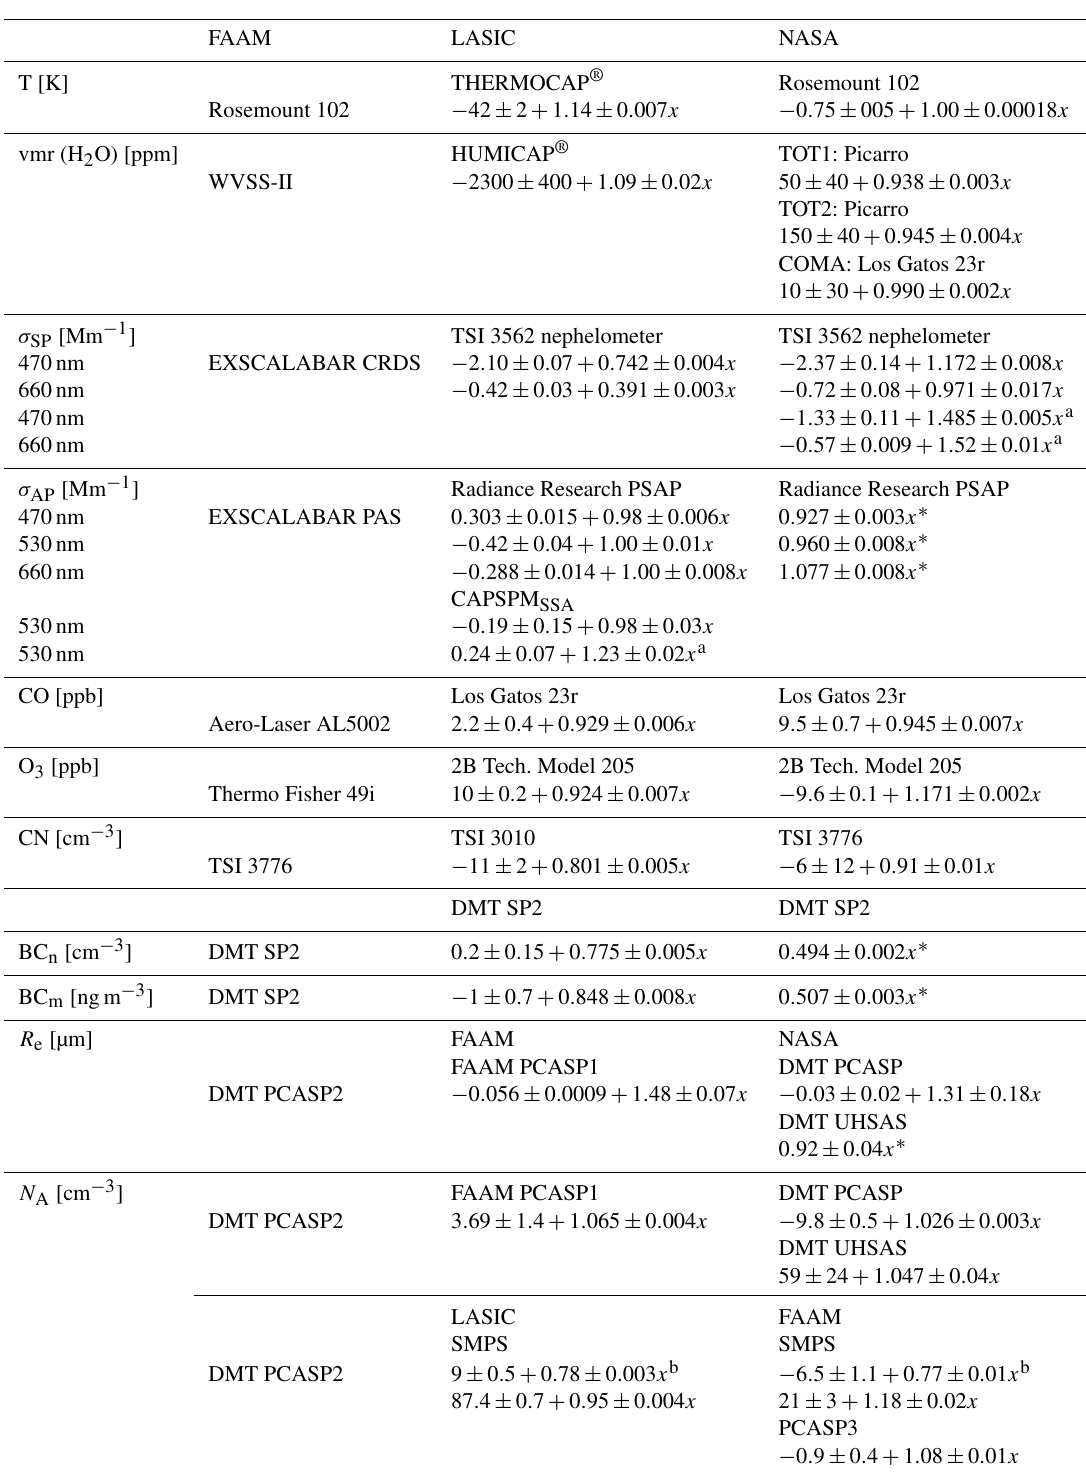
Table 3. Summary of orthogonal distance regression or ratios of weighted means between observations from FAAM : NASA and FAAM : LASIC comparisons. Particle observations are for PM 1 unless otherwise